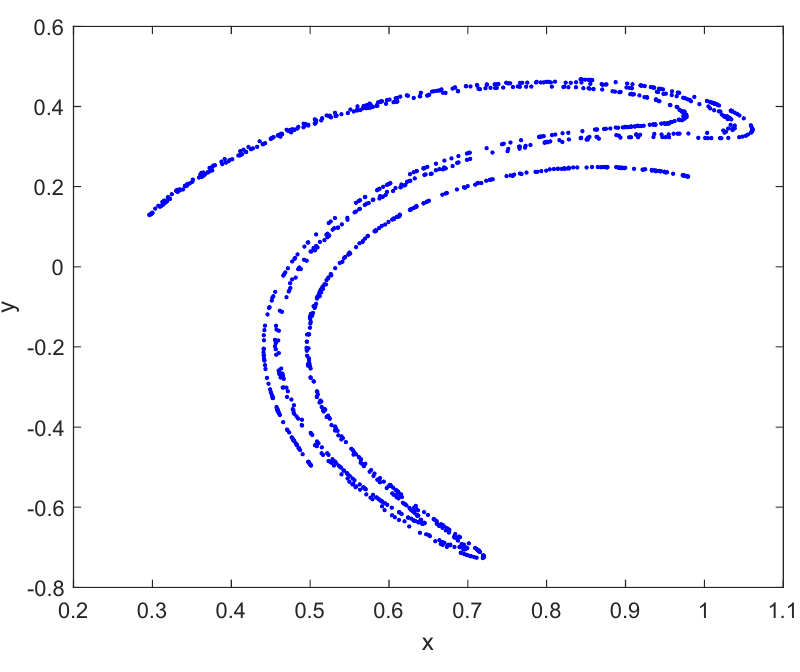
Figure 1. Plot of the Ikeda map.